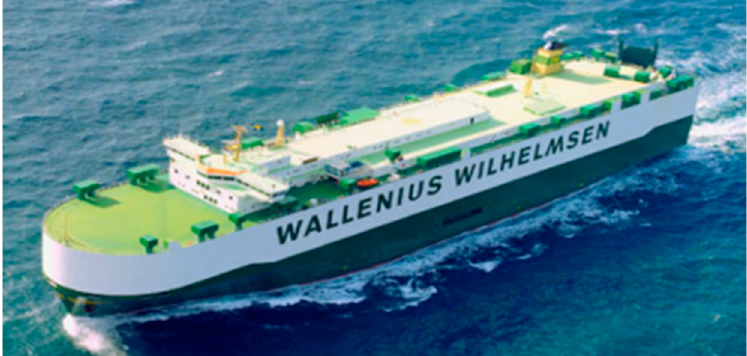
Figure 12. The car carrier “Undine” [73].